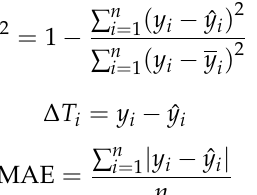
where T B 2 M ( t ) is the transient temperature of B2M, and T A 2 M ( t ) is the transient temper- ature of A2M. The coefficient of determination ( R 2 ), the temperature difference between experimental data and predicted data ( ∆ T ), and the mean absolute error (MAE) are used to evaluate the model accuracy, and they are expressed as follows: